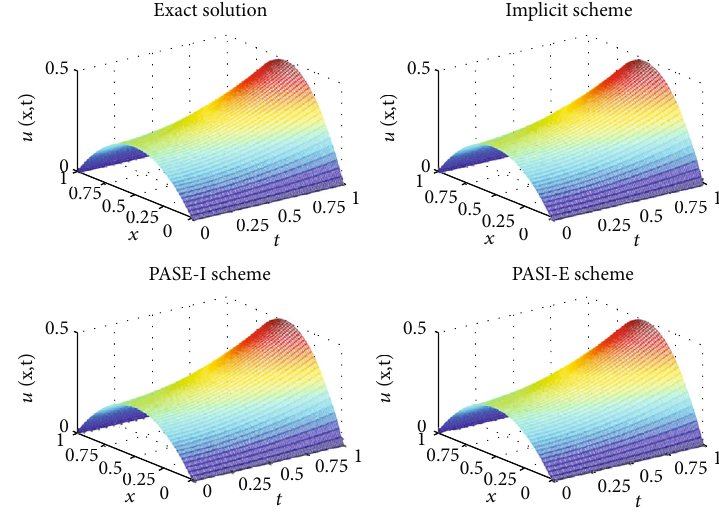
Figure 2: Exact and numerical solutions of surfaces ( M = 50 , N = 100